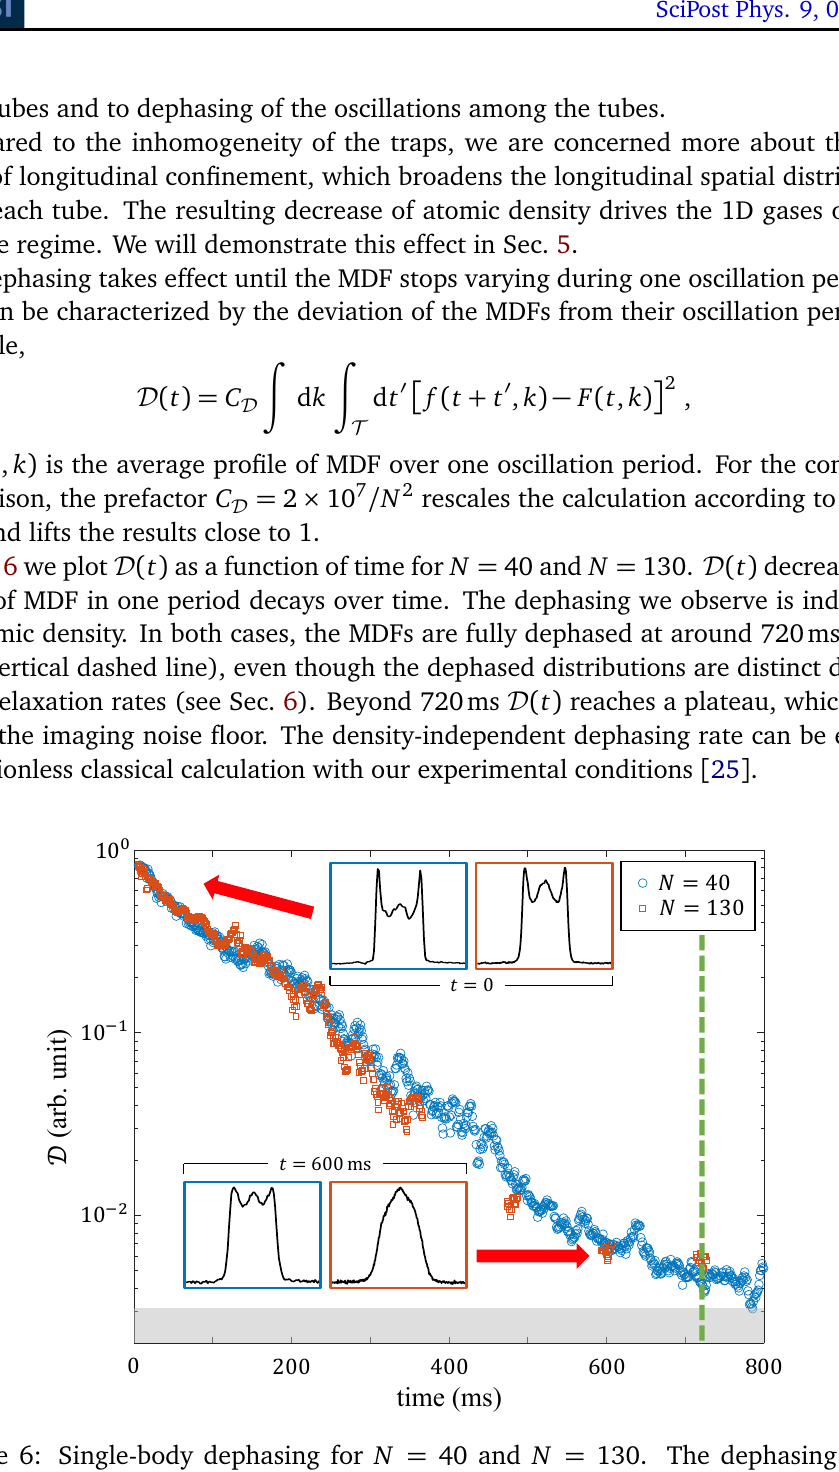
Figure 6: Single-body dephasing for N = 40 and N = 130. The dephasing rate is nearly independent of the atomic density. The insets show the oscillation period averaged MDFs at the indicated evolution times, and the boxes’ colors indicate the corresponding data-sets. After about 720ms (marked with the green dashed line), the MDF does not significantly vary over time anymore. The shaded area indicates the noise